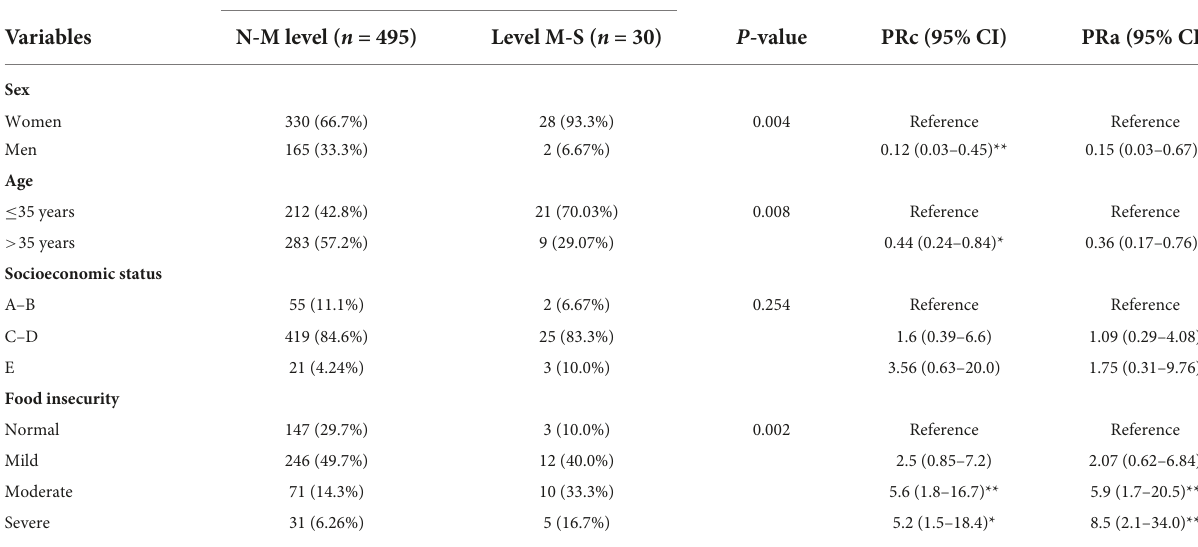
TABLE 4 Association between the level of food insecurity and stress.